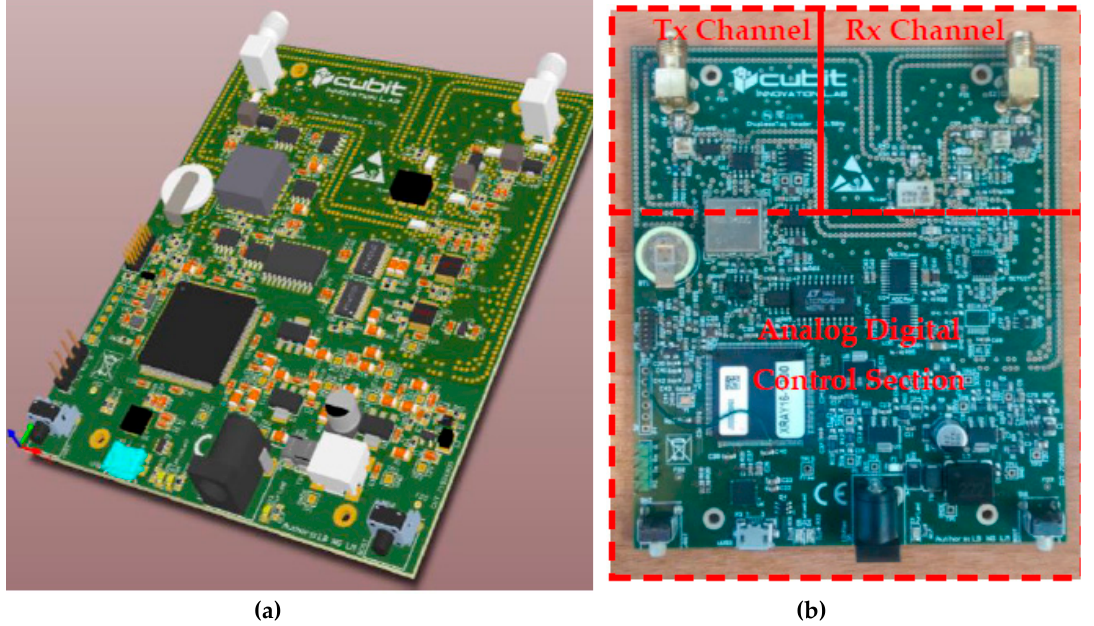
Figure 2. Portable reader developed for frequency domain chipless tags. ( a ) 3D Rendering, ( b ) Printed Circuit Board Assembled.